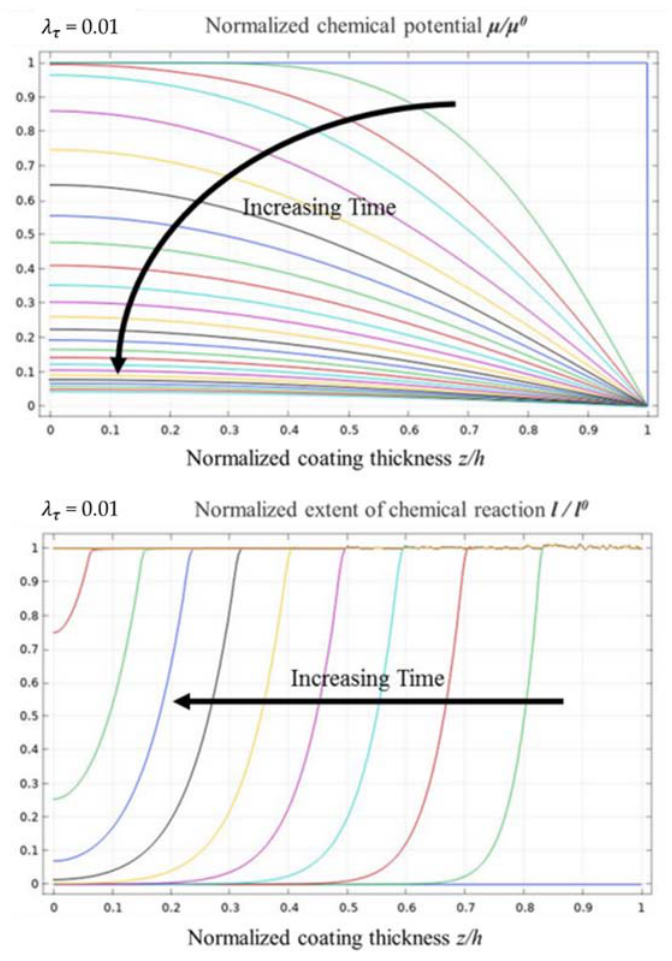
Figure 7. Evolution curves of normalised chemical potential and normalised chemical reaction degree when λ (cid:2980) = 0.01.